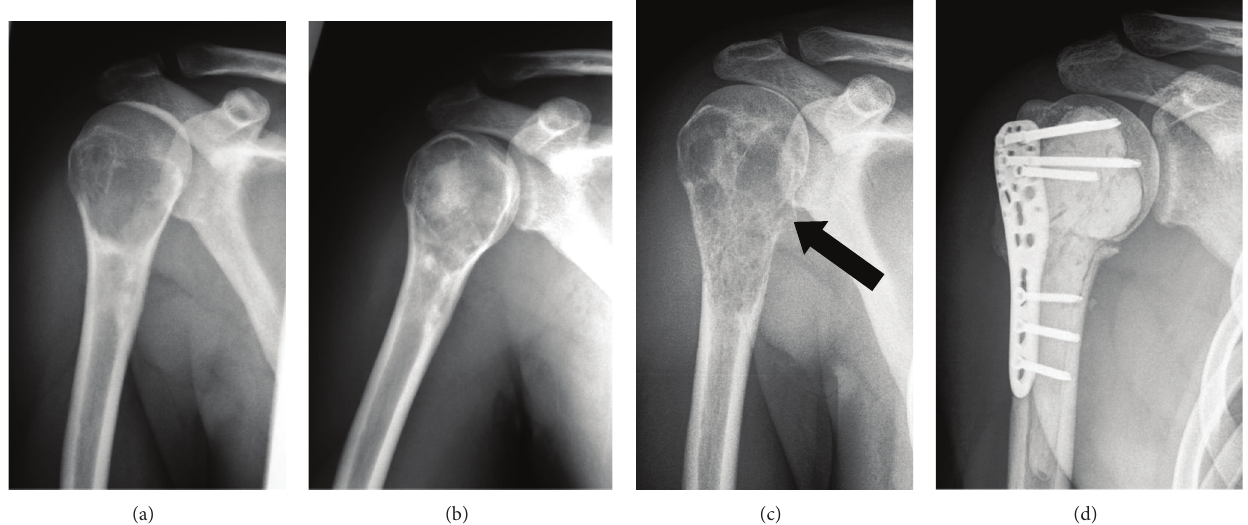
Figure 1: Conventional radiography, AP view of the proximal right humerus: (a) lytic lesion of the proximal humerus, (b) after curettage and filling the defect with cancellous bone graft, (c) presenting with pathological fracture (arrow) four months later, and (d) the lesion was curetted and the cavity was filled with bone cement.